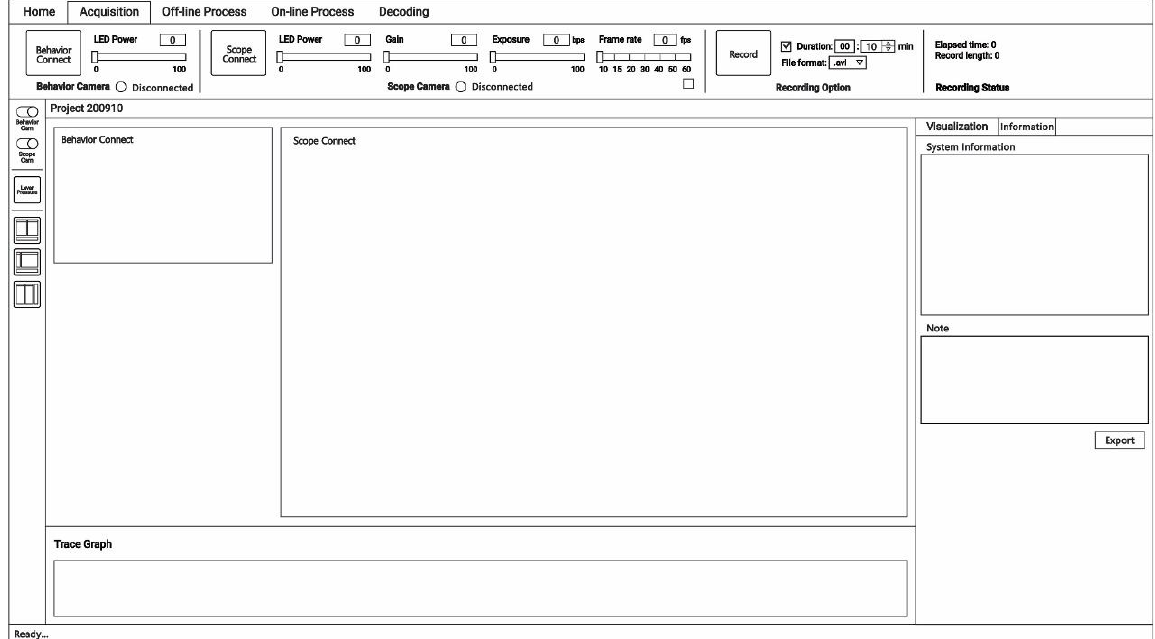
Figure 3. A wireframe design of data acquisition module for a new O-BMI system (illustrated).